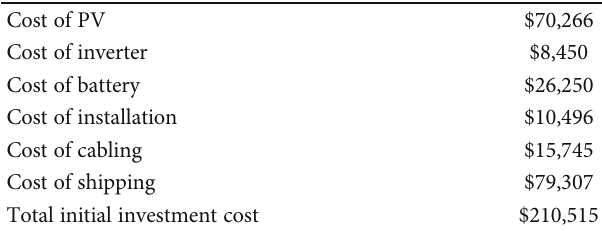
Table 3: Detail initial investment cost of BAPV system design 1 in scenario